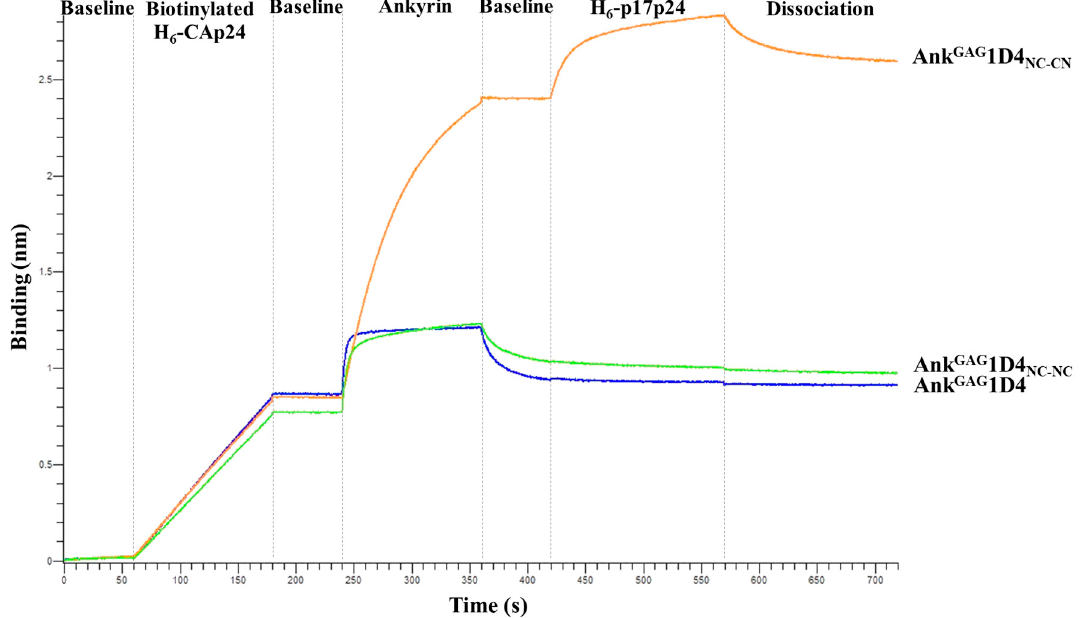
Figure 4. Binding characteristics of monomeric Ank GAG 1D4, dimeric Ank GAG 1D4 NC-NC , and Ank GAG 1D4 NC-CN . Ligand binding of monomeric and dimeric Ank GAG 1D4 is demonstrated by a sand-